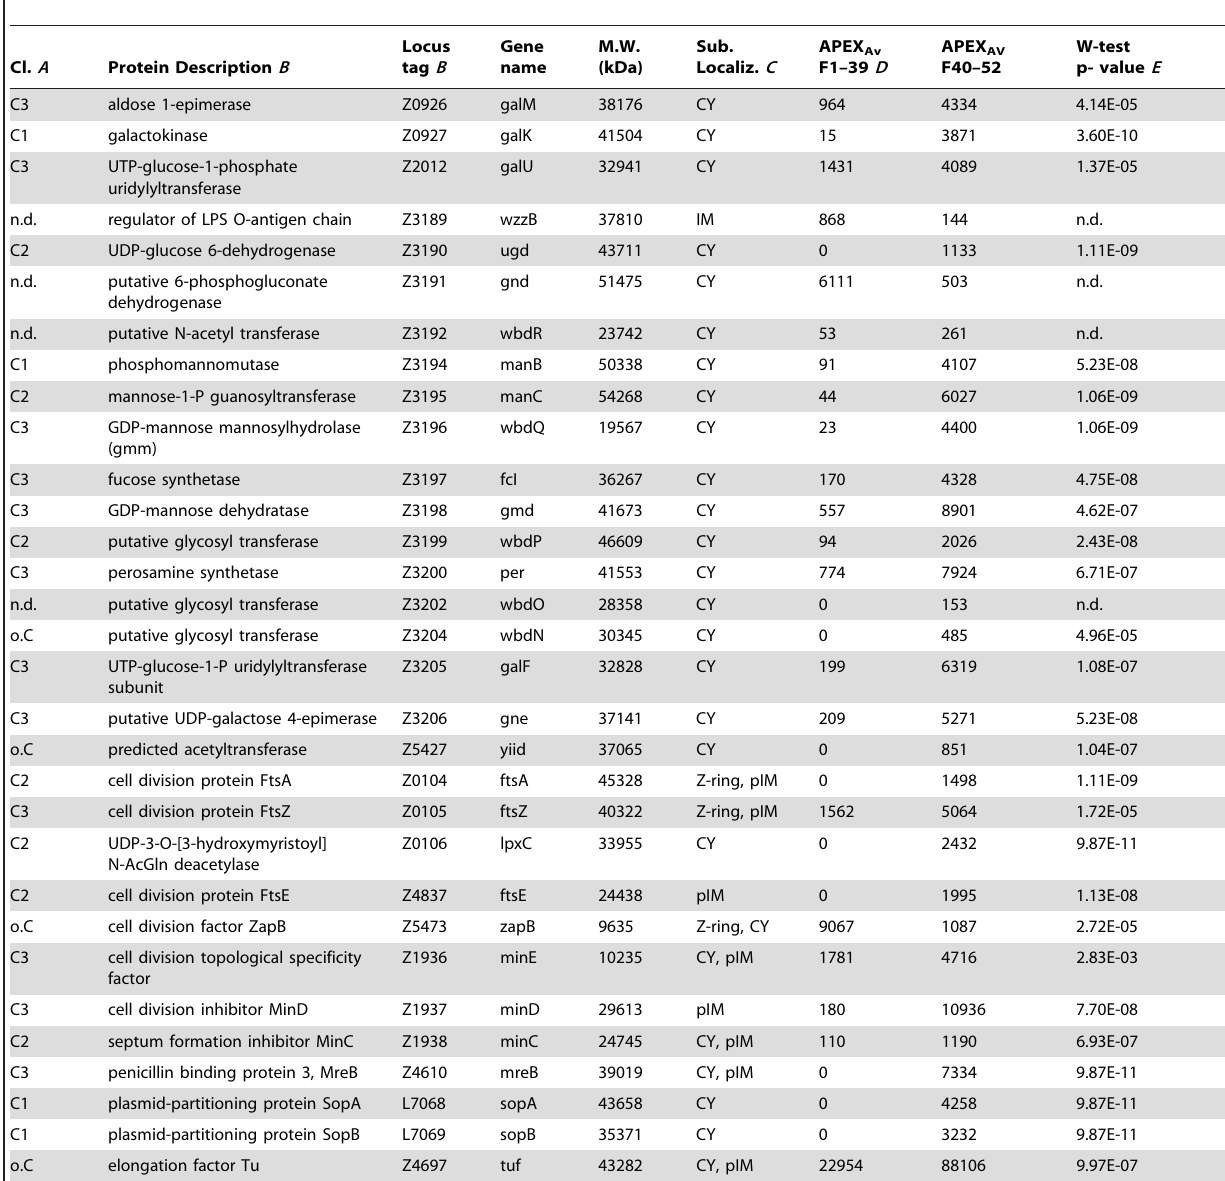
Table 3. Proteins predicted to participate in multi-protein structures such as cell division and O-antigen biosynthesis, and prone to aggregation based on relative abundance in insoluble E. coli O157:H7